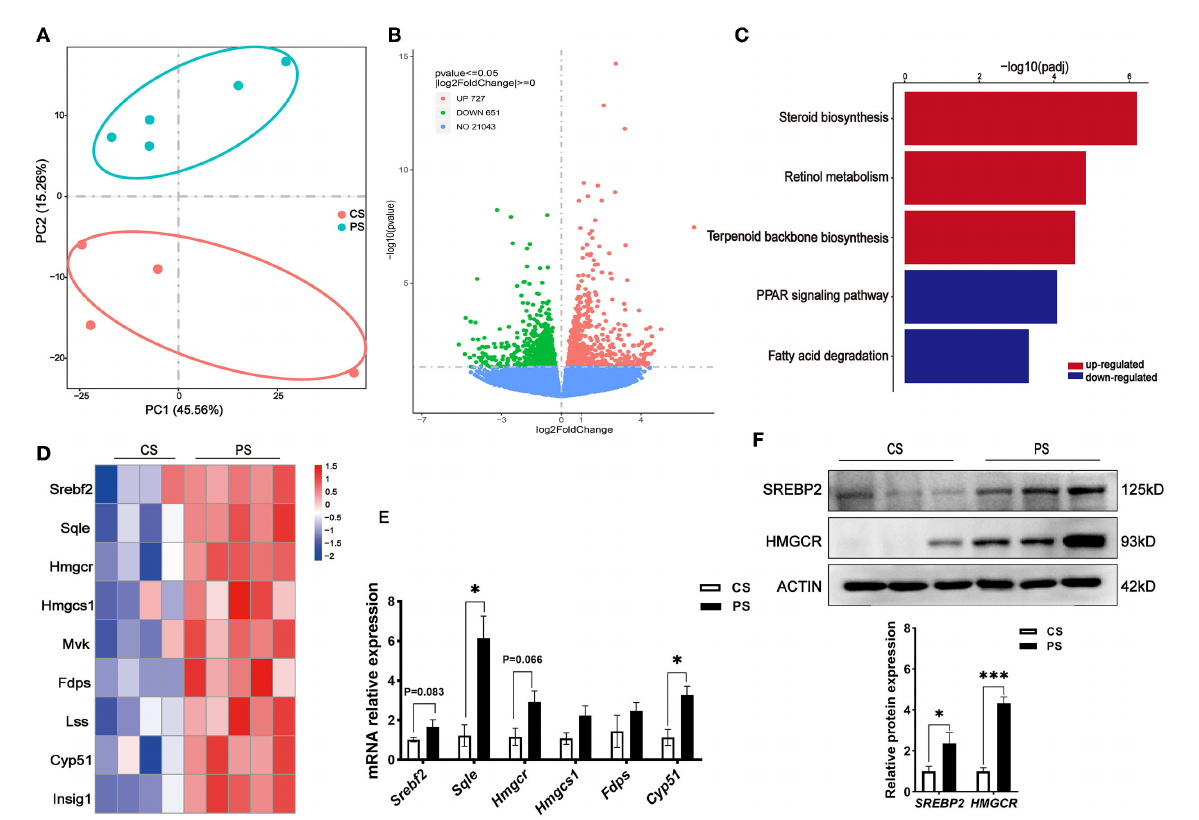
FIGURE3 Response of the liver transcriptome to different dietary phytosterol intakes. (A) Principal component analysis (PCA) score plots of the whole transcriptomic dataset in the liver. Each dot represents an observation (animal) projected onto the first (horizontal axis) and second (vertical axis) PCA variables. (B) Volcano plot of differentially expressed genes in the liver of CS and PS group mice. Colors indicate p < 0.05 and fold change > 1 (red), p < 0.05 and fold change < 1 (green), and non-significant (blue). (C) Representative bar charts of lipid metabolism-related pathways enriched by KEGG analysis in the liver. Red and blue colors indicate upward and downward revisions, respectively. (D) Heatmap of genes involved in cholesterol synthesis. (E) Validation of gene expression in the liver derived from RT-qPCR assay. (F) Western blot analysis of SREBP2 and HMGCR proteins in the liver and the quantitative densitometric analysis normalized against β -actin. n = 3 mice/group, the results are presented as the mean ± SEM, representative of three independent experiments, * p < 0.05, *** p <